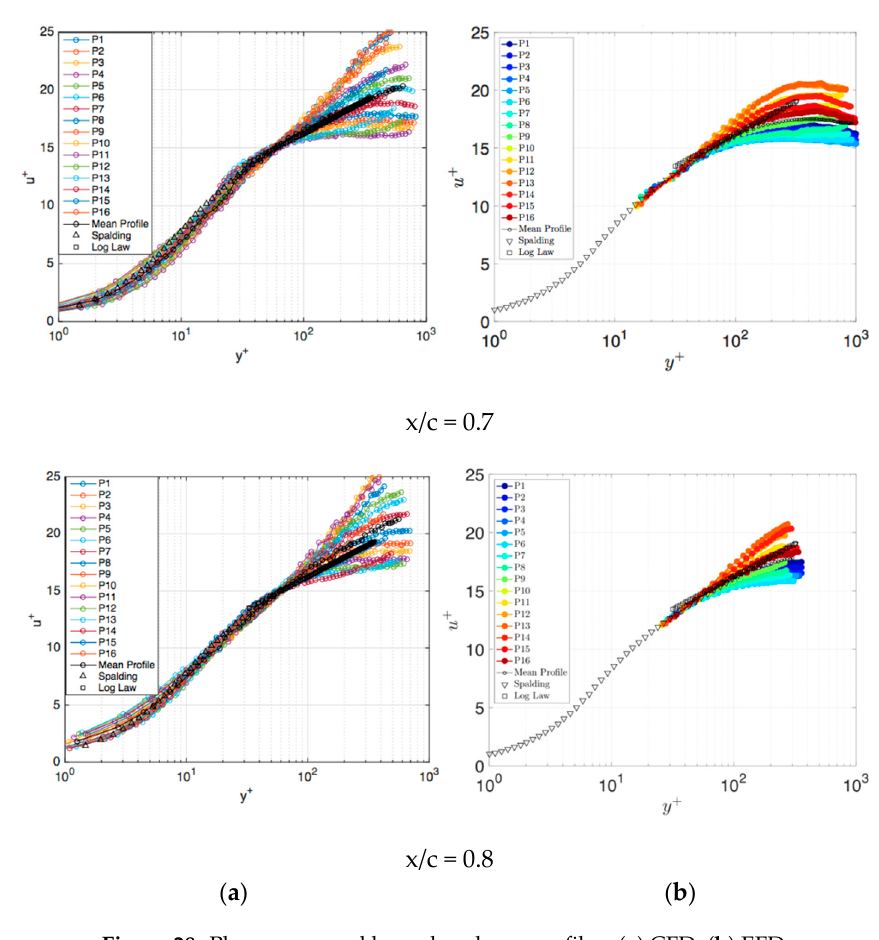
Figure 28. Phase-averaged boundary layer profiles. ( a ) CFD; ( b ) EFD.